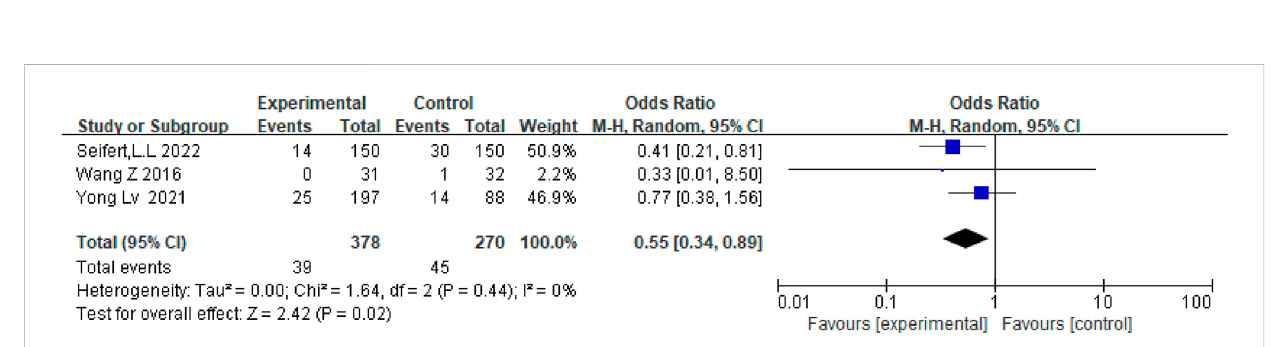
FIGURE 12 Effect of anticoagulation or antiplatelet treatment on 1 year death after TIPS.